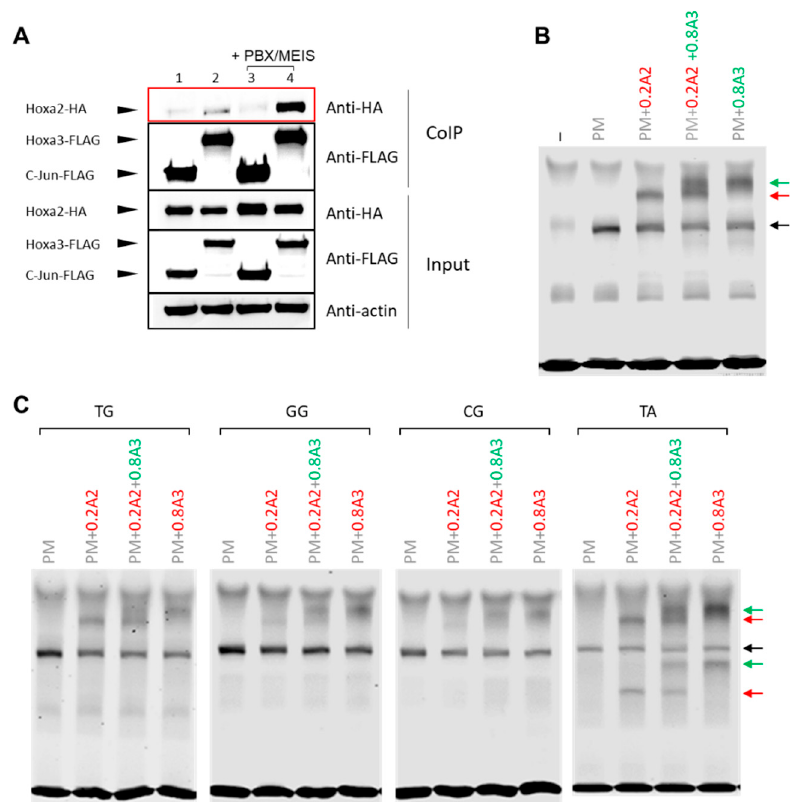
Figure 4. HOXA2 and HOXA3 form a complex with PBX and MEIS. ( A ) Co-precipitation assay. HEK293T cells were transfected with expression vectors for FLAG-and HA-tagged proteins. Proteins were analysed by western blotting before (input) and after (CoIP) co-precipitation using an anti-FLAG antibody. All conditions contain Hoxa2-HA in the presence of Jun-FLAG (1, 3), Hoxa3-FLAG (2,4); Meis1 and Pbx1 were added to conditions 3, 4. Jun represents a negative control. ( B ) HOXA2 and HOXA3 binding to Meis2 probe when there is a 4x excess of HOXA3 and both are incubated for 5 min prior to the addition of PBX/MEIS (PM) and the probe. HOXA3 is unable to displace HOXA2. No tetrameric complex is observed. Black arrows indicate PBX/MEIS dimer, red and green arrows indicate HOXA2 and HOXA3 interactions with the probe, respectively. ( C ) Experiment in ( B ) repeated with the Meis2 mutant variants detailed in Figure 1B.